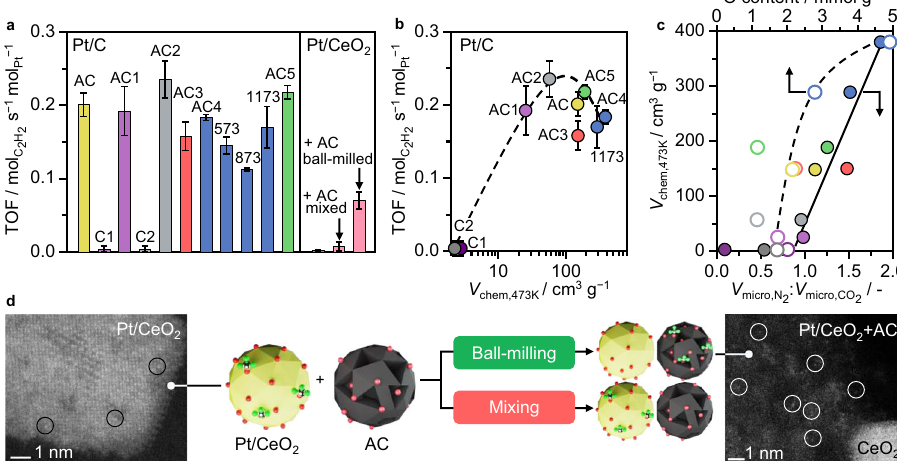
Fig. 2 Activity descriptors for Pt/C catalysts in acetylene hydrochlorination. a Initial activity, expressed as the turnover frequency, TOF. b Correlation between catalytic activity and acetylene adsorption capacity, as determined by volumetric chemisorption at reaction temperature, V chem,473K . Error bars indicate the respectively lowest and highest activity obtained within three independent measurements. c Acetylene adsorption capacity as a function of the total oxygen content (open symbols) and the micropore accessibility, described as the ratio of the micropore volume, obtained from N 2 or CO 2 sorption (solid symbols). d Proximity effects between an active carbon support, AC, and the optimal metal nanostructure (Pt single atoms, circled) hosted on an inactive support (shown for CeO 2 , but also applicable to the inactive carbon supports C1 or